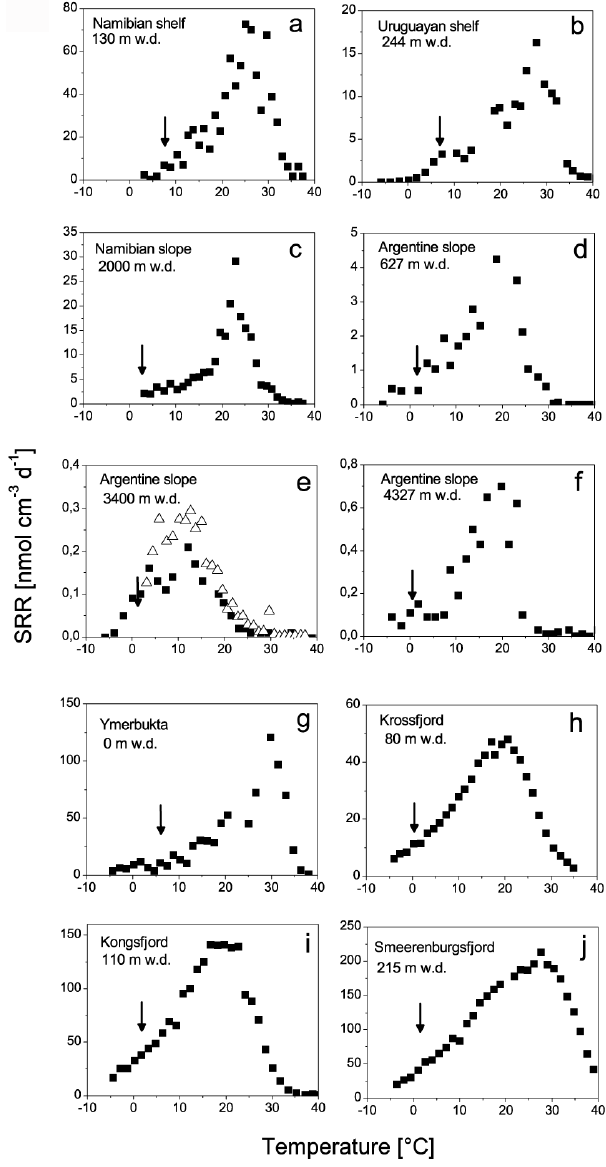
Fig. 1. SRR measured in temperature-gradient incubation experi- ments of sediment slurries from the different sampling sites. Ar- rows indicate in situ temperatures of sediments, w.d. stands for wa- ter depth. Argentine Basin sediment from the depth 3400m was incubated twice and a duplicate curve was added to the panel (e)